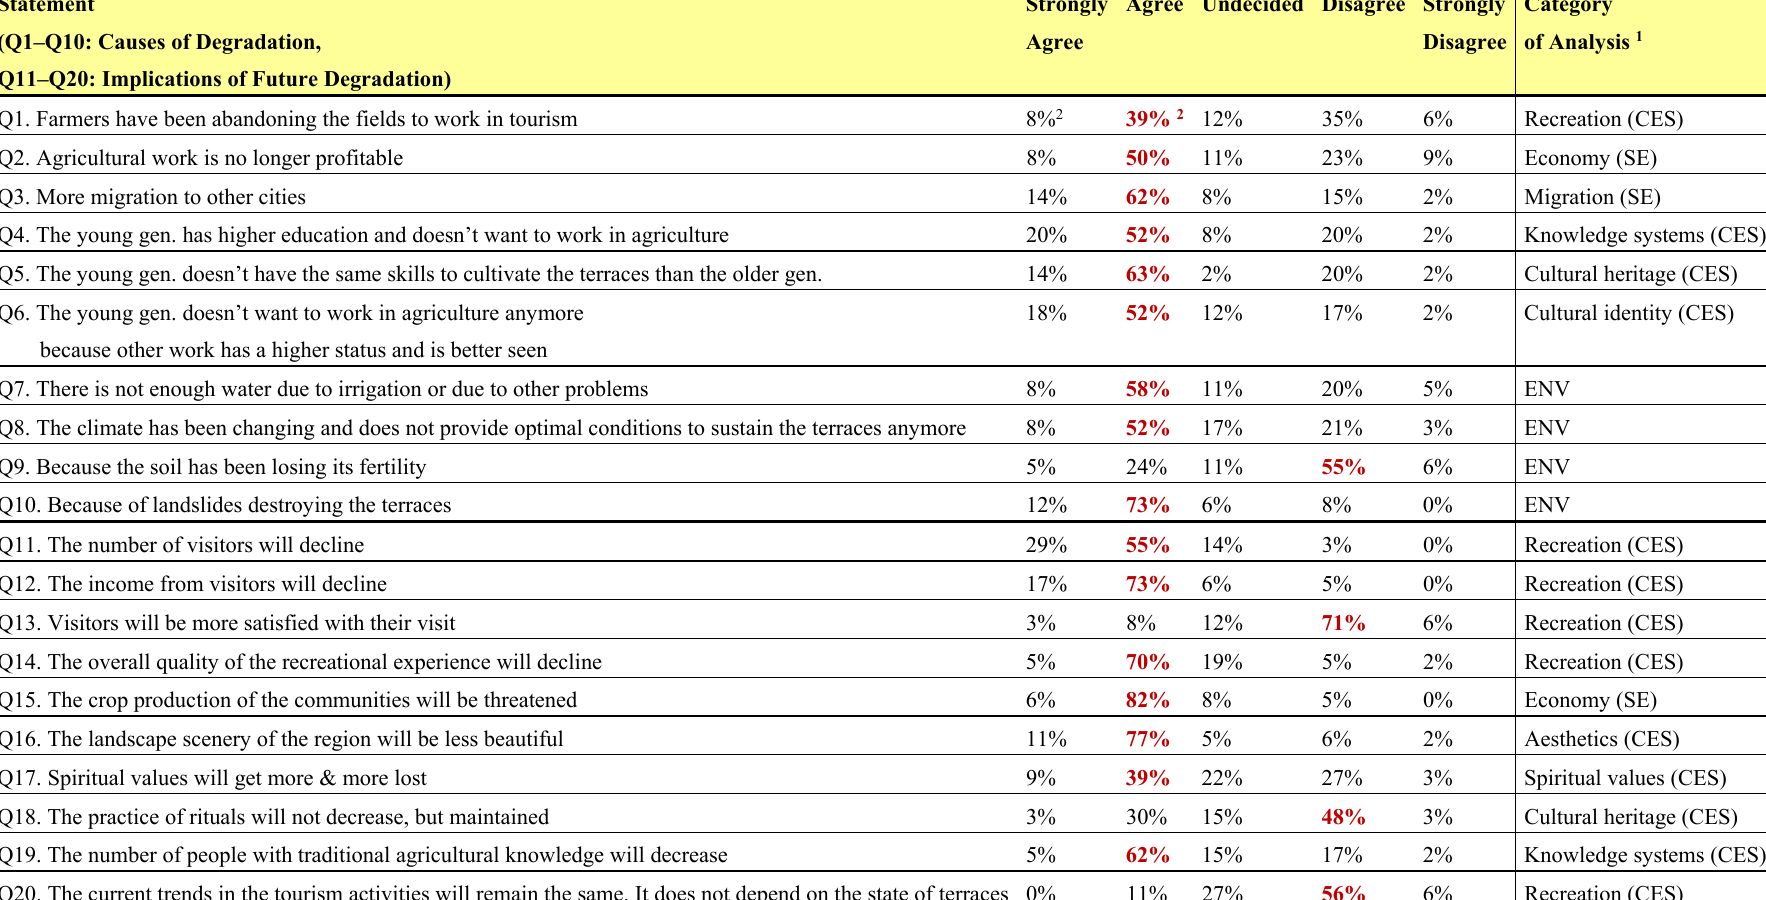
Table 1. Frequency distribution of all statements in the survey, in percentages for the responses to each statement. Note: (1) Categories of analysis include: CES categories, environmental conditions (ENV) and socioeconomic aspects (SE). The environmental and socioeconomic aspects were included in order to avoid neglecting important elements. (2) The most frequent responses appear in bold red font. Numbers are rounded up (Source: Own